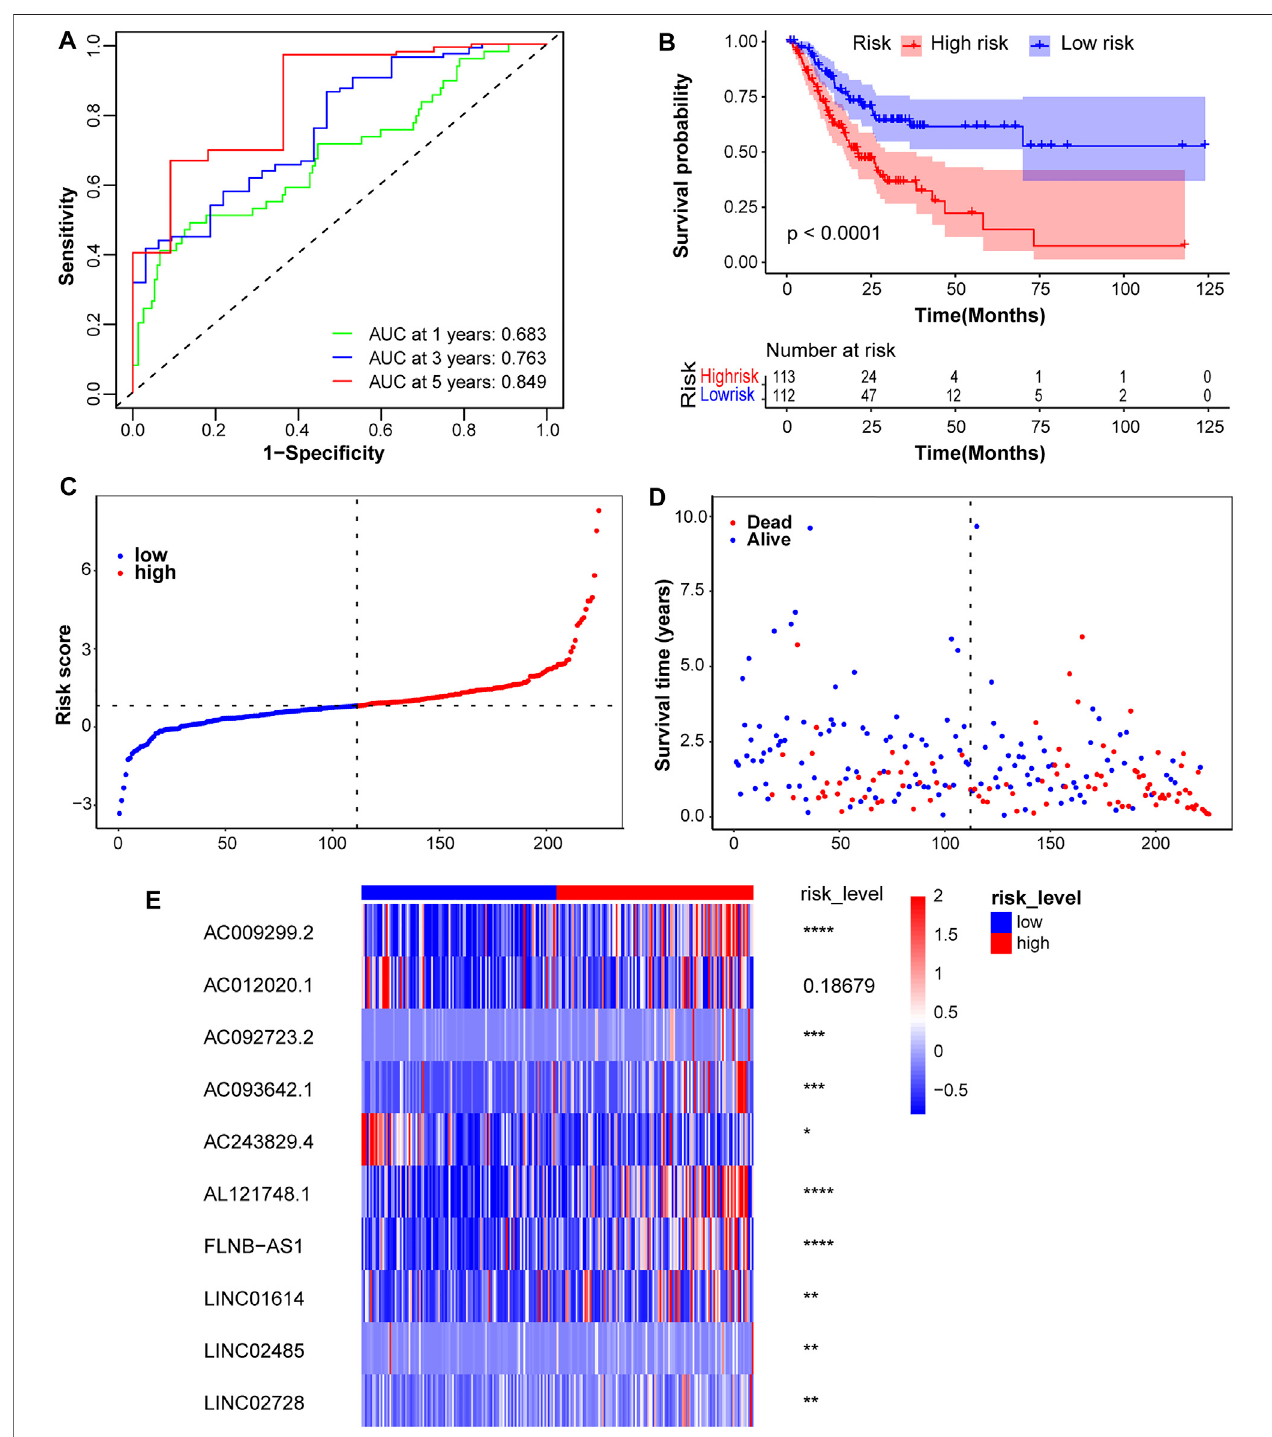
FIGURE 3 | Assessment of the prognostic model in the training cohort. (A) Time-independent ROC curves along with their AUC were conducted to assess the sensitivity and speci fi city. (B) The KM survival curves showed a higher survival rate in the low-risk group. (C) Risk scores for patients with STAD were presented in ascending order. (D) The survival status distribution curve showed a higher proportion of dead patients in the high-risk group. (E) The expression heatmap of these 10 lncRNAs was plotted and signi fi cance levels were annotated on the right side. **** p < 0.0001, *** p < 0.001, ** p < 0.01, * p < 0.05.